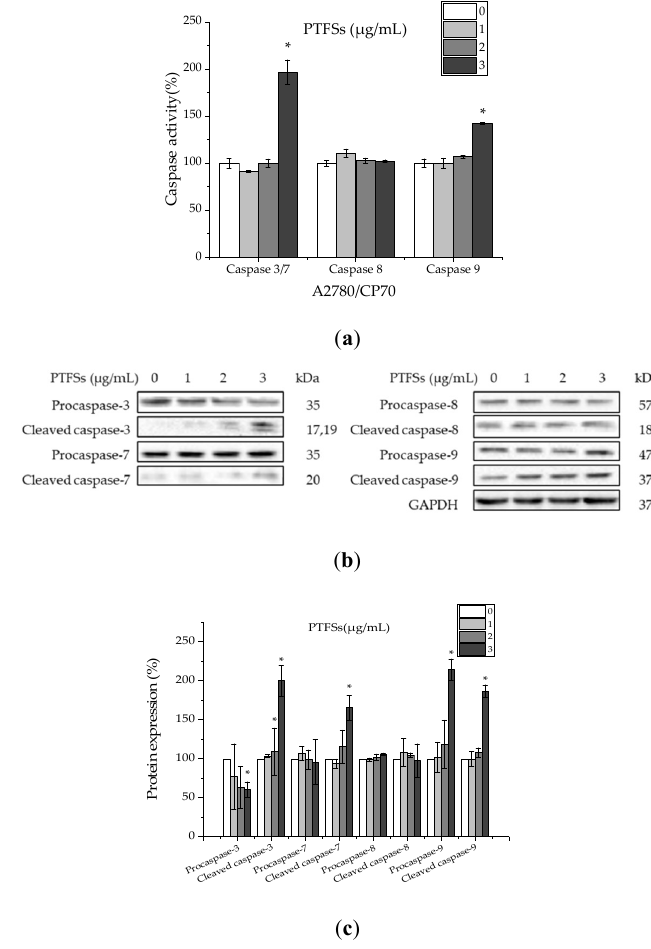
Figure 4. The e ff ect of PTFSs on caspase activities in A2780 / CP70 cells. ( a ) Cells were treated with PTFSs (0, 1, 2, and 3 µ g / mL) for 24 h and the activities of caspase-3 / 7, -8 and -9 were determined. The caspase 3 / 7, -8, -9 activities of control cells were expressed as 100%. ( b , c ) E ff ects of PTFSs (0, 1, 2, 3 µ g / mL) on the expression of caspase-3, -7, -8 and -9 were assayed by Western blotting. GAPDH was utilized for an endogenous reference to standardize protein levels. All values are shown as mean ± SEM of three independent experiments. * p < 0.05 versus control. Cells treated with culture medium containing 0.01% dimethyl sulfoxide (DMSO) was used as the